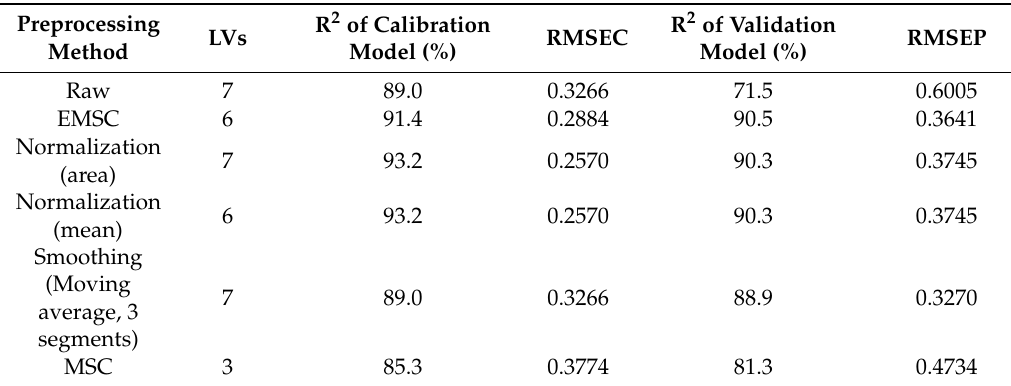
Table 1. Statistical parameters of partial least squares discriminant analysis models discriminate green coffee beans species using near-infrared spectra.